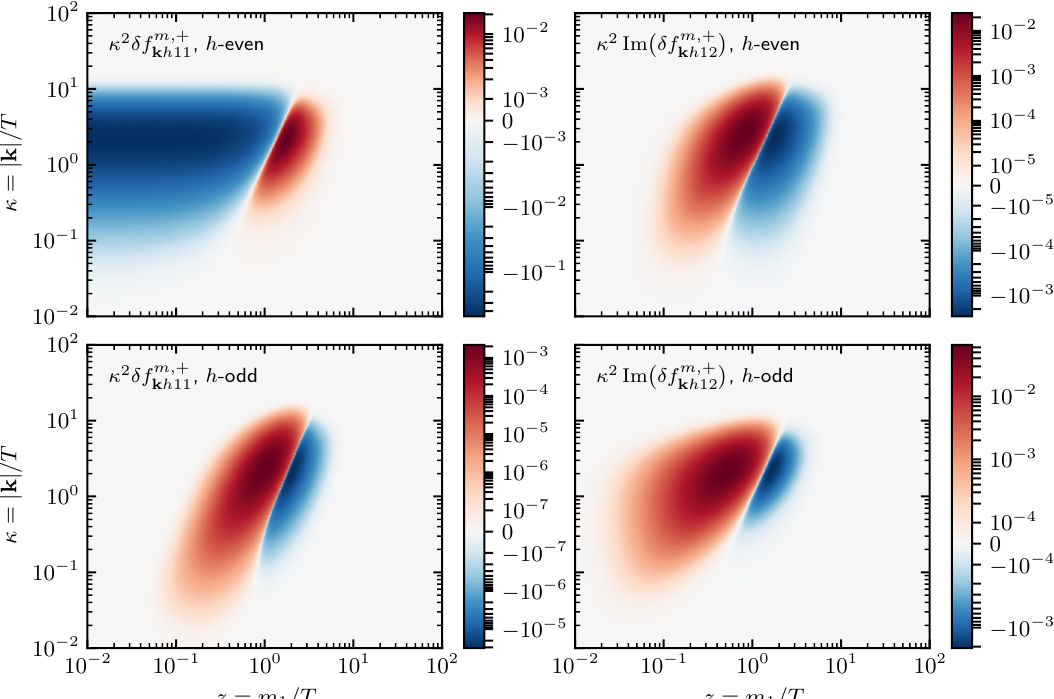
Figure 5. Shown are select components of the numerical solution δf m, + equation (6.10) with vacuum initial conditions. Left and right sides show the flavour-diagonal function δf k ,h 11 and the off-diagonal function Im( δf k ,h 12 ) , respectively. Top row features the helicity-even combination ( δf k , +1 + δf k , − 1 ) / 2 and the bottom row the helicity-odd